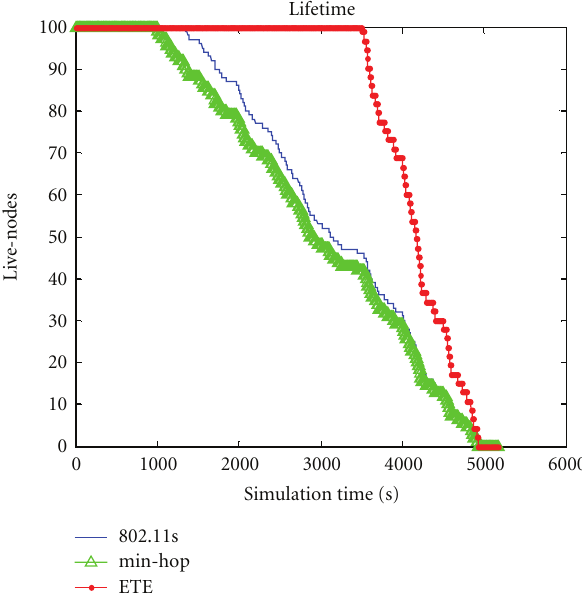
Figure 5: Lifetime of